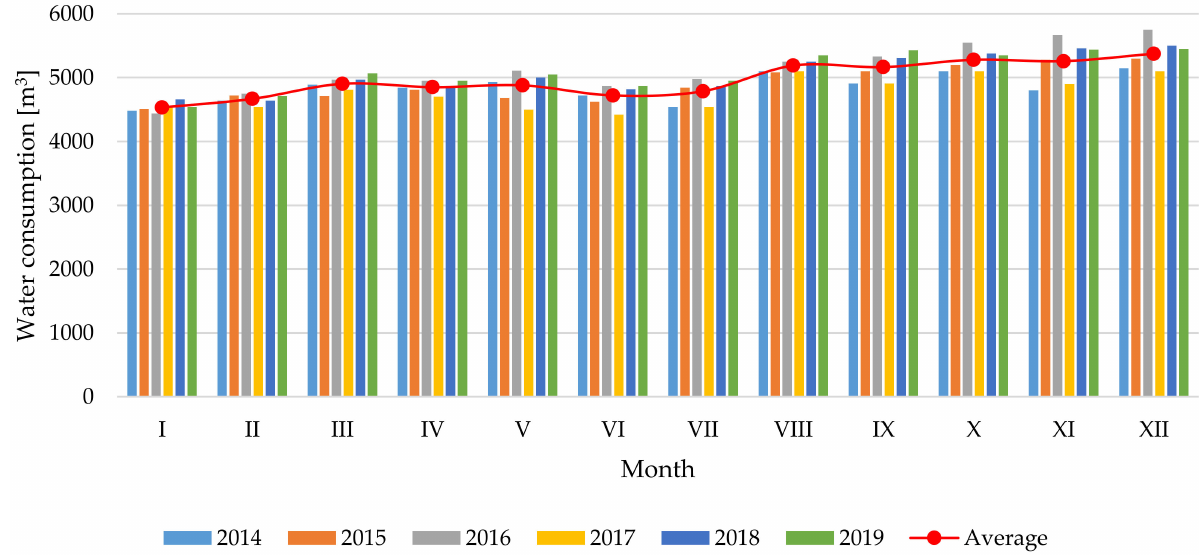
Figure 5. Measured water consumption in a hotel facility in